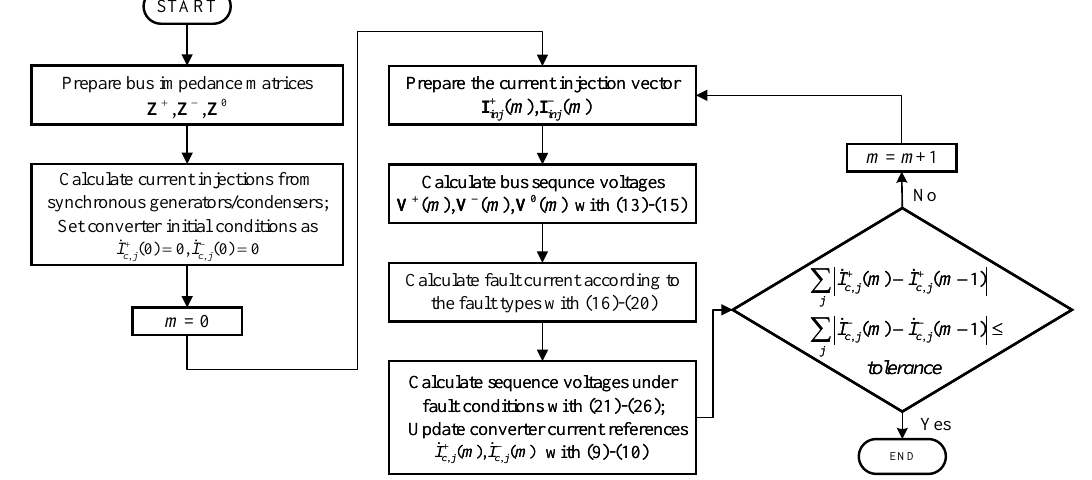
Figure 2. Flowchart of the proposed fault analysis